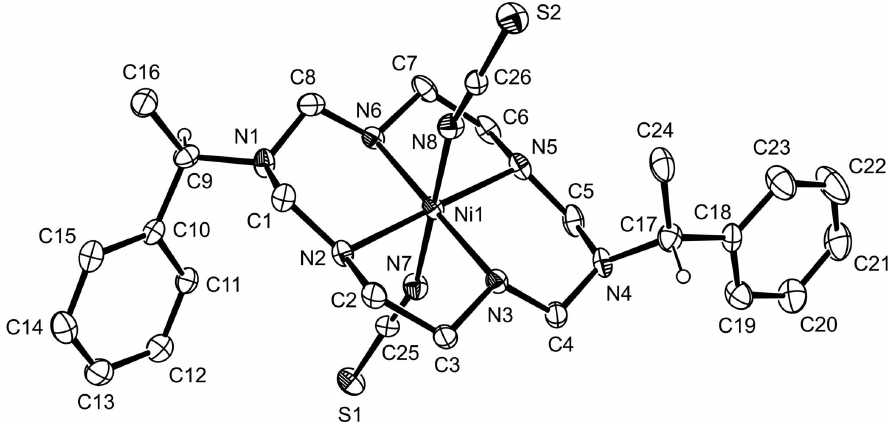
Figure 1 ORTEP drawing of the molecular title compound with atomic numbering scheme and ellipsoids at 40% probability.